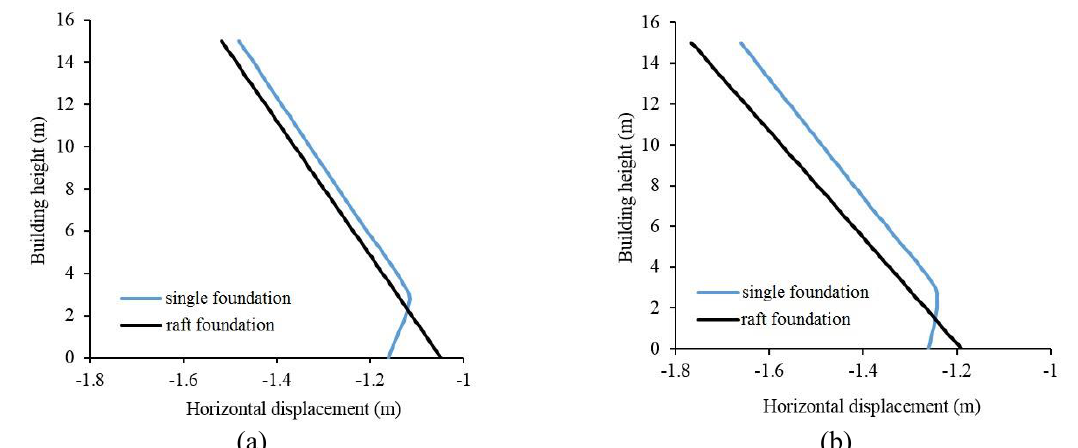
Fig. 22. Comparison of lateral displacement of structure for 5 floor building with single and raft foundations: (a) LS-MS and (b) DS-LS.